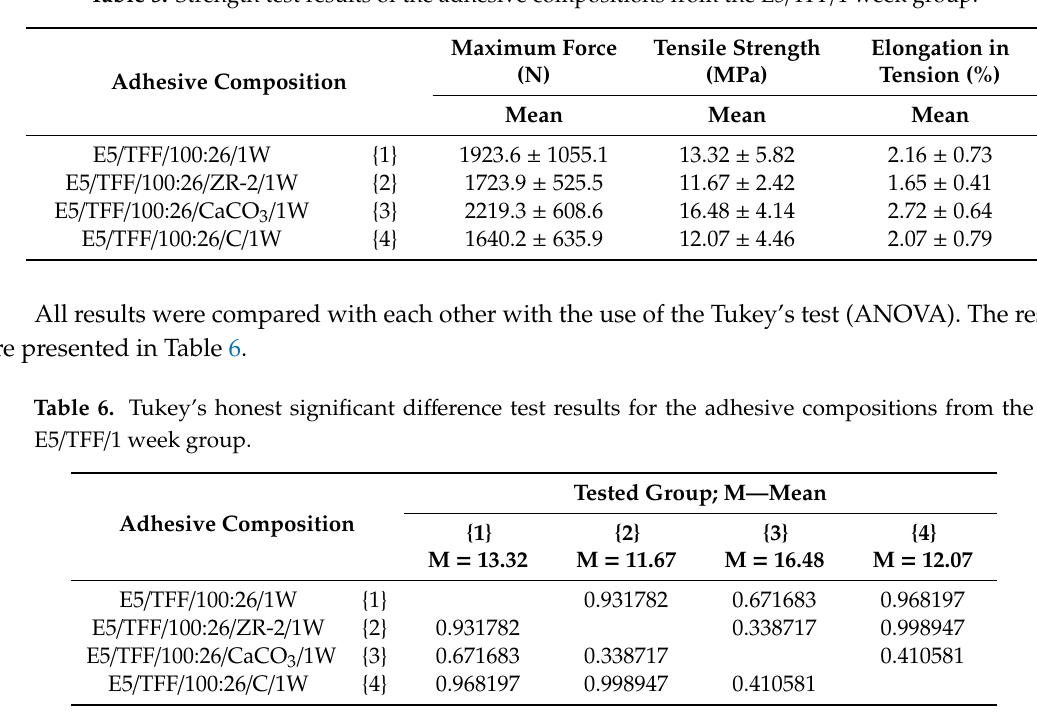
Table 5. Strength test results of the adhesive compositions from the E5 / TFF / 1 week group.